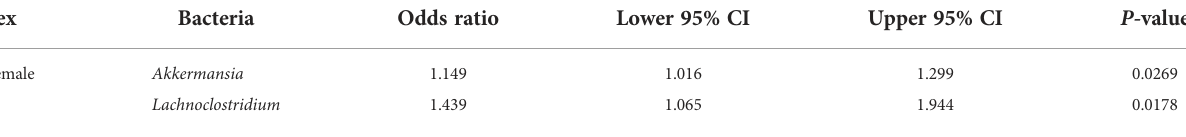
TABLE 3 Bacteria selected by the least absolute shrinkage and selection operator logistic model. Sex Bacteria Odds ratio Lower 95% CI Upper 95% CI P-